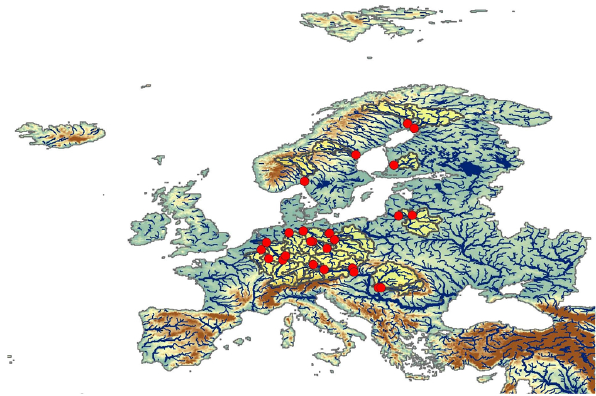
Fig. 1. Geographical distribution of the GRDC gauging stations used for analysis, the corresponding catchment areas are high- lighted in